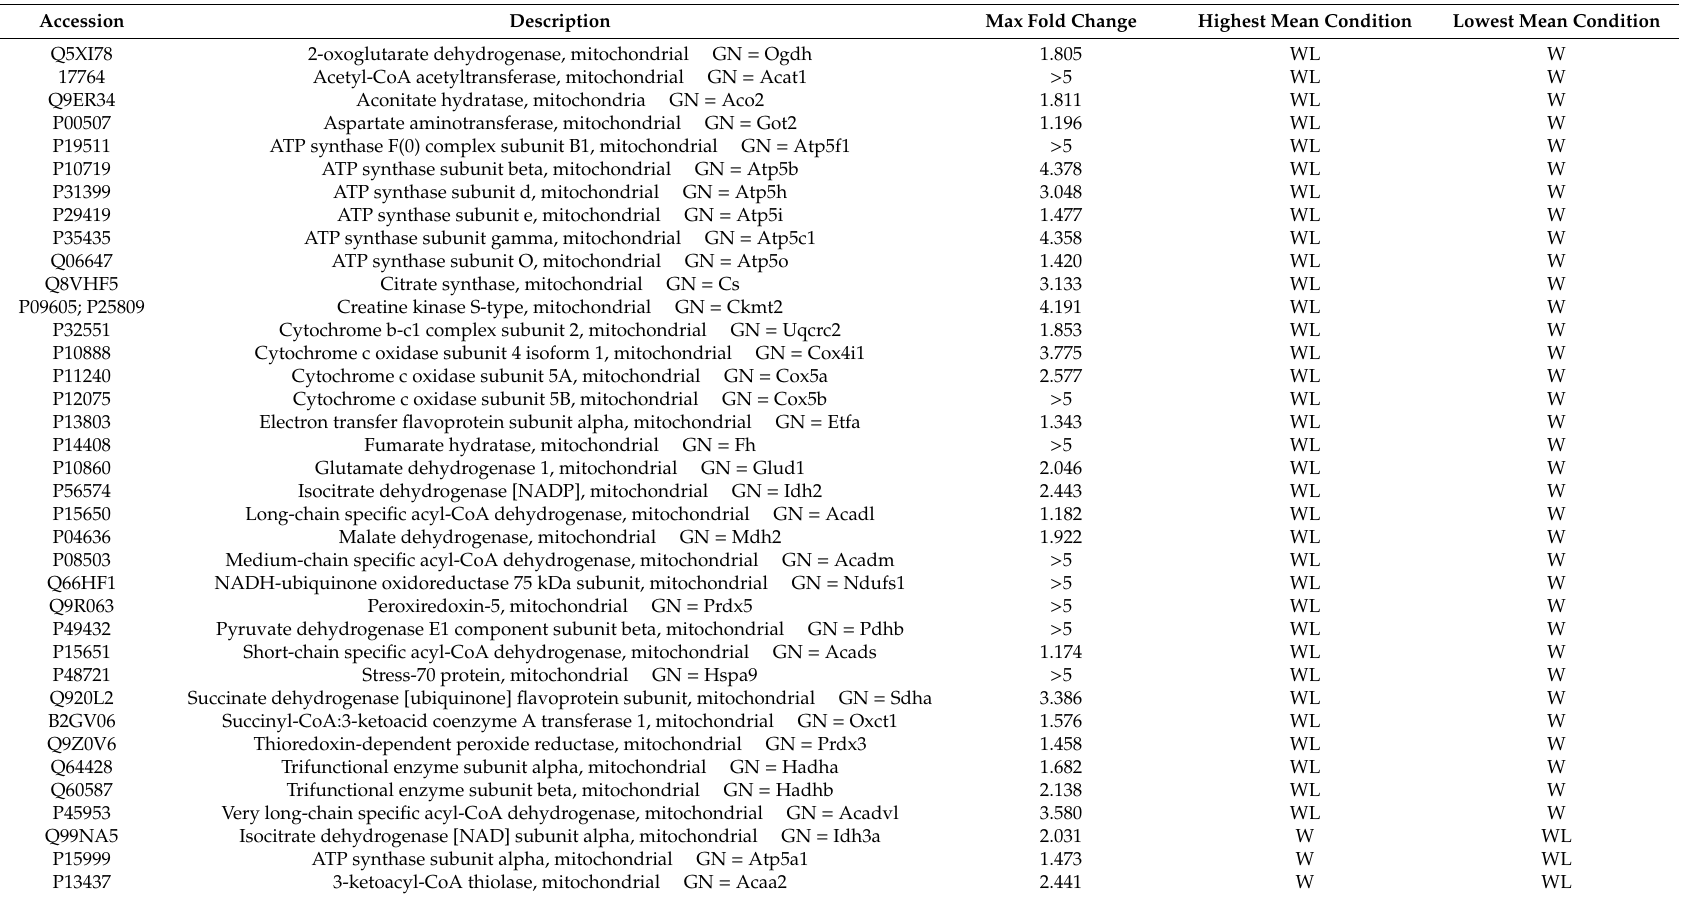
Table 2. The highest and lowest mitochondrial proteins concentration identified in rats with Walker tumour-bearing fed / not fed a leucine-rich diet and euthanatised at 21st day of the